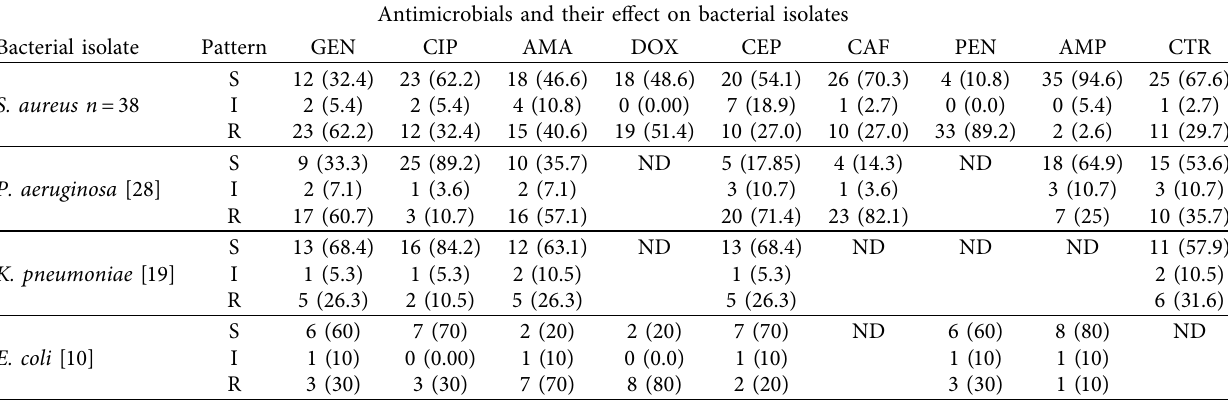
Table 4: Antimicrobial resistance pattern of surface-borne bacterial isolates over ICU and OT at WSUCH, Wolaita Sodo, Ethiopia, 2021. Antimicrobials and their efect on bacterial isolates Bacterial isolate